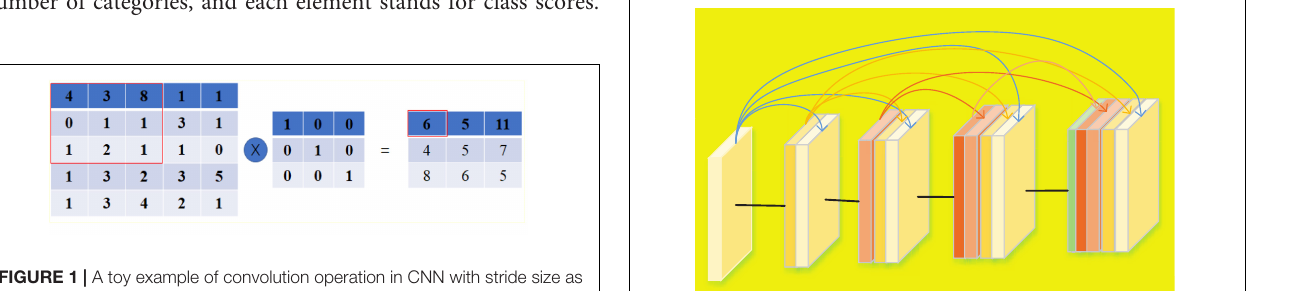
FIGURE 1 | A toy example of convolution operation in CNN with stride size as 1, in which, the left matrix means the input, the second matrix means the kernel, and the right matrix stands for the generated feature map after convolution operation. It is different from the convolution defined in purely mathematic terms.